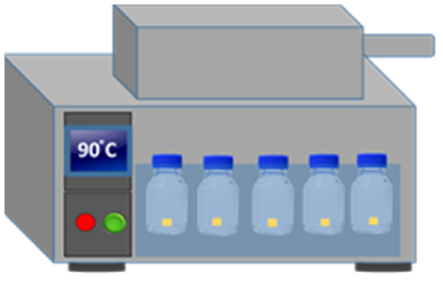
Figure 3. Solution immersion method.